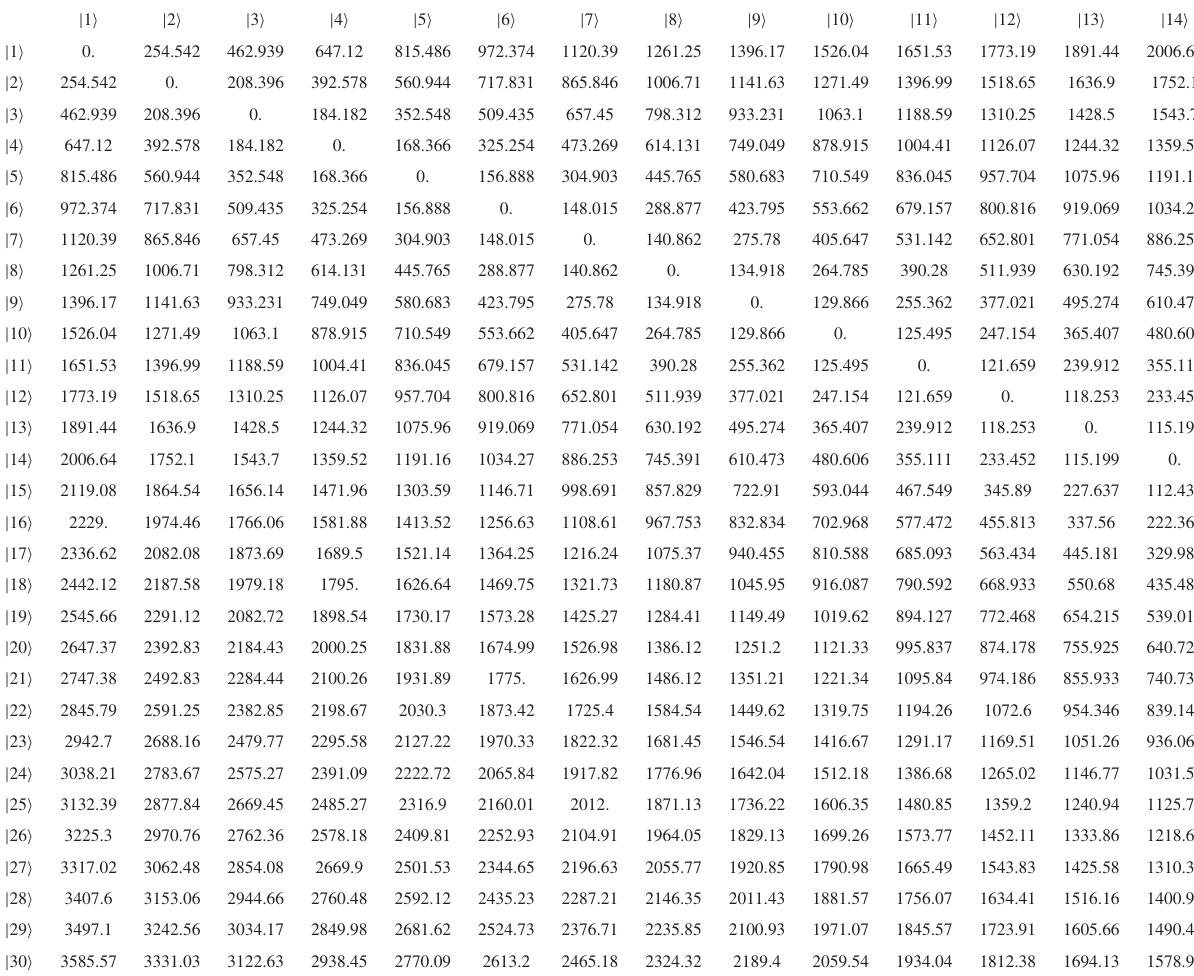
Table 3. Neutron’s intonation system based on accoustic resonant transitions [3], here in a 30 × 14 matrix M . Shown is the frequency range for transitions between | 14 (cid:4) ↔ | 15 (cid:4) at 112.45 Hz and | 1 (cid:4) ↔ | 30 (cid:4) at 3585.57 Hz spanning the piano key notes from A2 to A7 in Fig. 3. We can consider this matrix as an instrument, which is able to perform pieces of music with these frequencies, and perform “Happy Birthday to you” for the ultra-cold neutron. The frequencies have been calculated for the local gravity g = 9 . 80507 m/s 2 at our experimental setup PF2 in